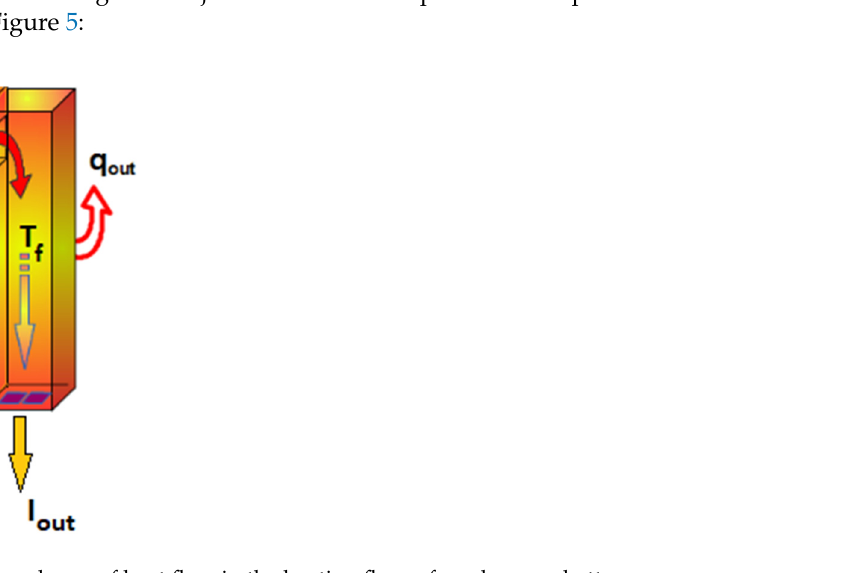
Figure 5. The scheme of heat flow in the heating flues of a coke oven battery.